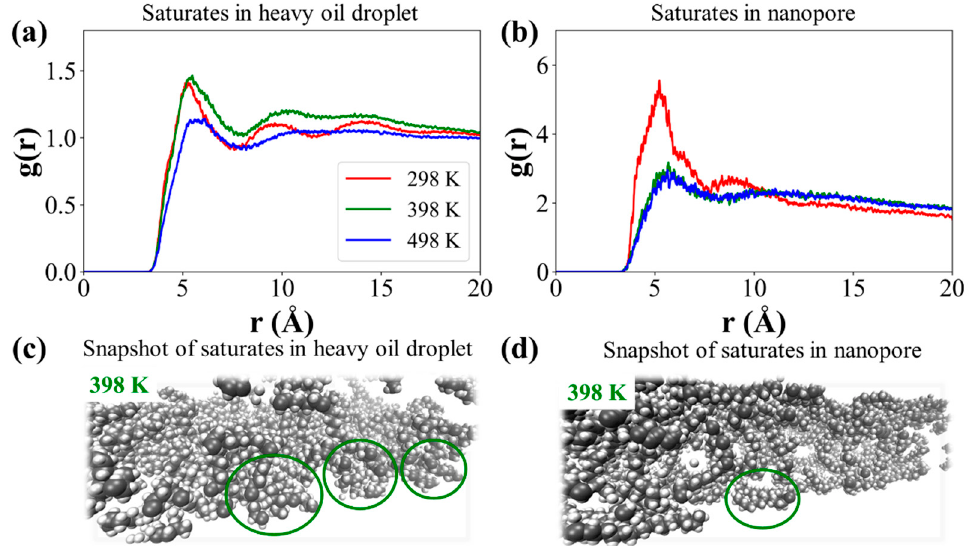
Figure 7. RDFs of saturate molecule pairs in ( a ) heavy oil droplet and ( b ) nanopore at 298 K, 398 K, and 498 K, respectively; the snapshots of saturate molecules in ( c ) heavy oil droplet and ( d ) nanopore at 398 K.